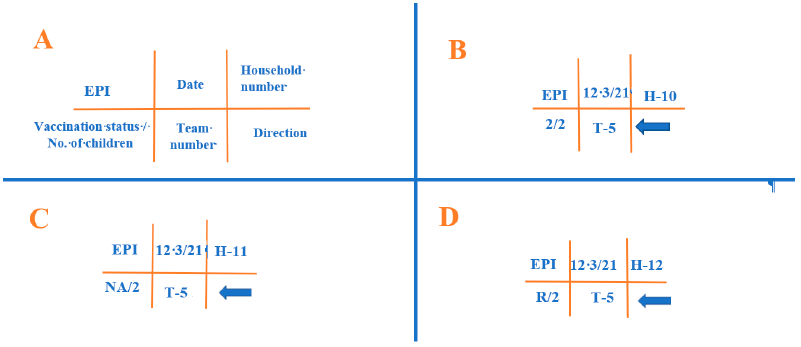
Figure 1. Description of H-household chalking used by the mobile vaccination team across